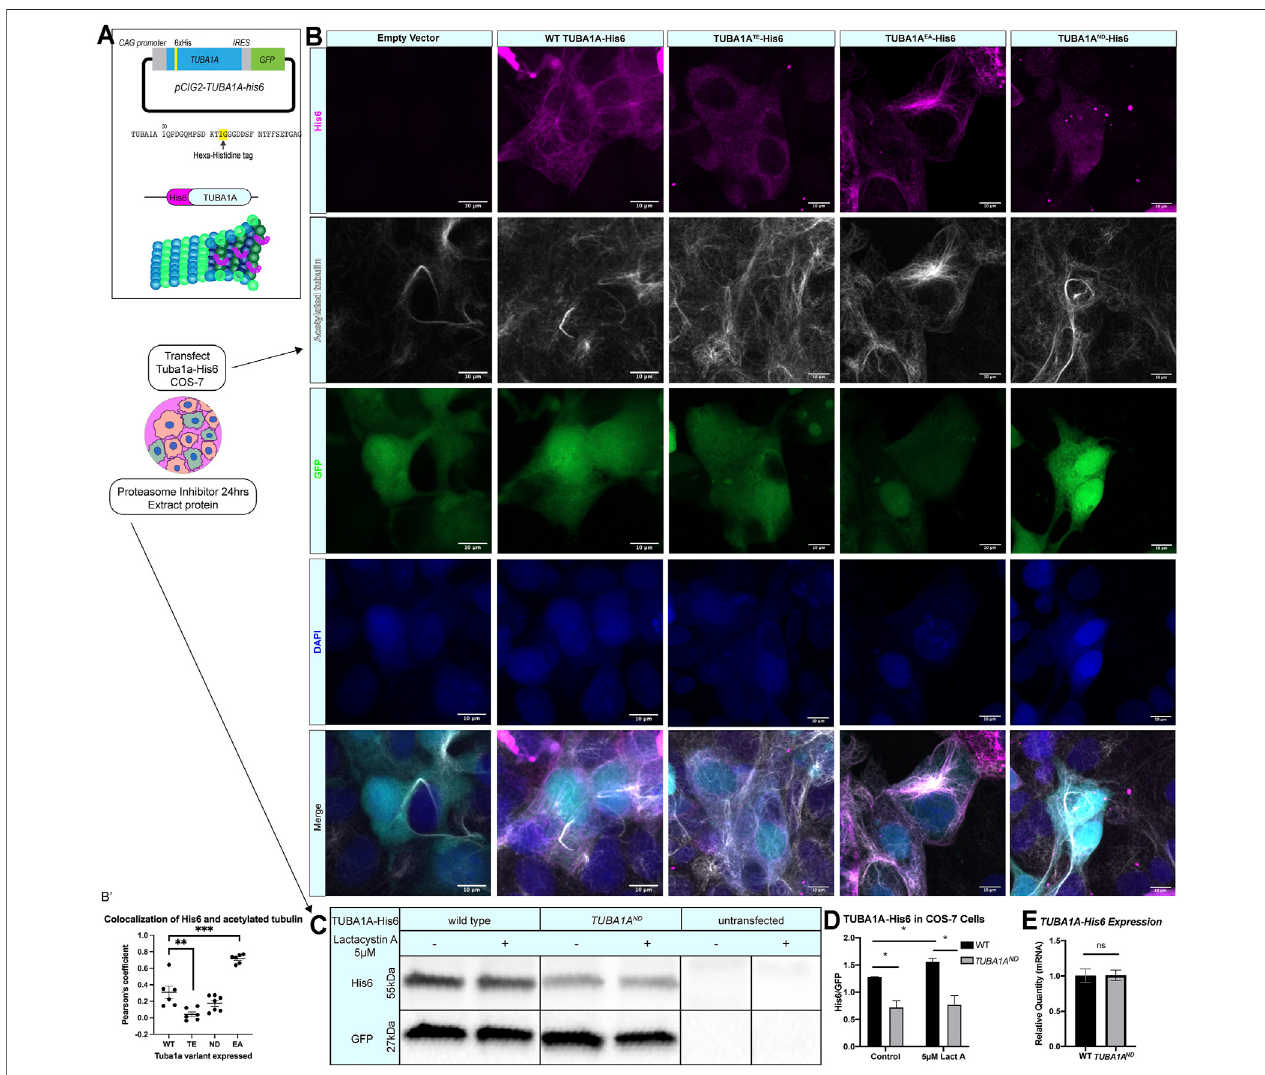
FIGURE 1 | TUBA1A ND impairs incorporation into cellular microtubules and reduces α -tubulin protein abundance. (A) Schematic of TUBA1A -His6 tag and experimental design. His6 epitope tag wasadded to an internal loop on TUBA1A (top), and TUBA1A-His6 plasmid DNA was transfected into Cos-7 cells to label cellular microtubulesinthepresenceorabsenceofproteasomeinhibitortreatment(bottom). (B) ImagesshowingCos-7cellstransfectedwithanemptyvectorcontrol,wild-type TUBA1A-His6 , TUBA1A TE -His6 (polymerization-incompetent mutant), TUBA1A EA -His6 (highly polymer stable mutant), and TUBA1A ND -His6 plasmid DNA. Cells were immunolabeled with α -His6 antibodies to reveal microtubule incorporation of wild-type and mutant TUBA1A-His6 protein. (B 9 ) Scatter plot showing the Pearsons ’ correlation coef fi cient to quantify the co-localization of acetylated tubulin with anti-His6 staining ** p < 0.01 and *** p < 0.001. (C) Western blot for His6 in TUBA1A-His6 transfected Cos-7 cell lysates. A subset of transfected cells were treated with 5 µM Lactacystin A (LactA) for 24 h to block proteasomal degradation. His6 signal was normalized to GFP, which was expressed from the same plasmid. (D) Quanti fi cation of band density for His6 western blot shown in (C) . His6 band density was normalized to GFP-expressing cells in control-treated (left), and cells treated with 5 µM LactA for 24 h (right). Data were analyzed by t test. N (cid:1) 3 transfections; n (cid:1) 3 technical replicates; p (cid:1) 0.04 for all comparisons marked with asterisks; p (cid:1) 0.83 for control vs. LactA-treated TUBA1A ND . (E) Bar graph representing TUBA1A mRNA expression in Cos-7 cells transfected with TUBA1A-His6. TUBA1A mRNA expression was normalized to GFP mRNA expression. Data were normalized to TUBA1A expressioninwild-type(WT)TUBA1A-His6-transfectedcellsandrepresent3separatetransfectionexperimentsand3qRT-PCRreplicates.Differencesbetweengroups were assessed by t test ( p (cid:1) 0.97). All images were taken at × 40 magni fi cation, scale bars are 10 µm. All graphs show mean of data ± SEM, * p < 0.05.